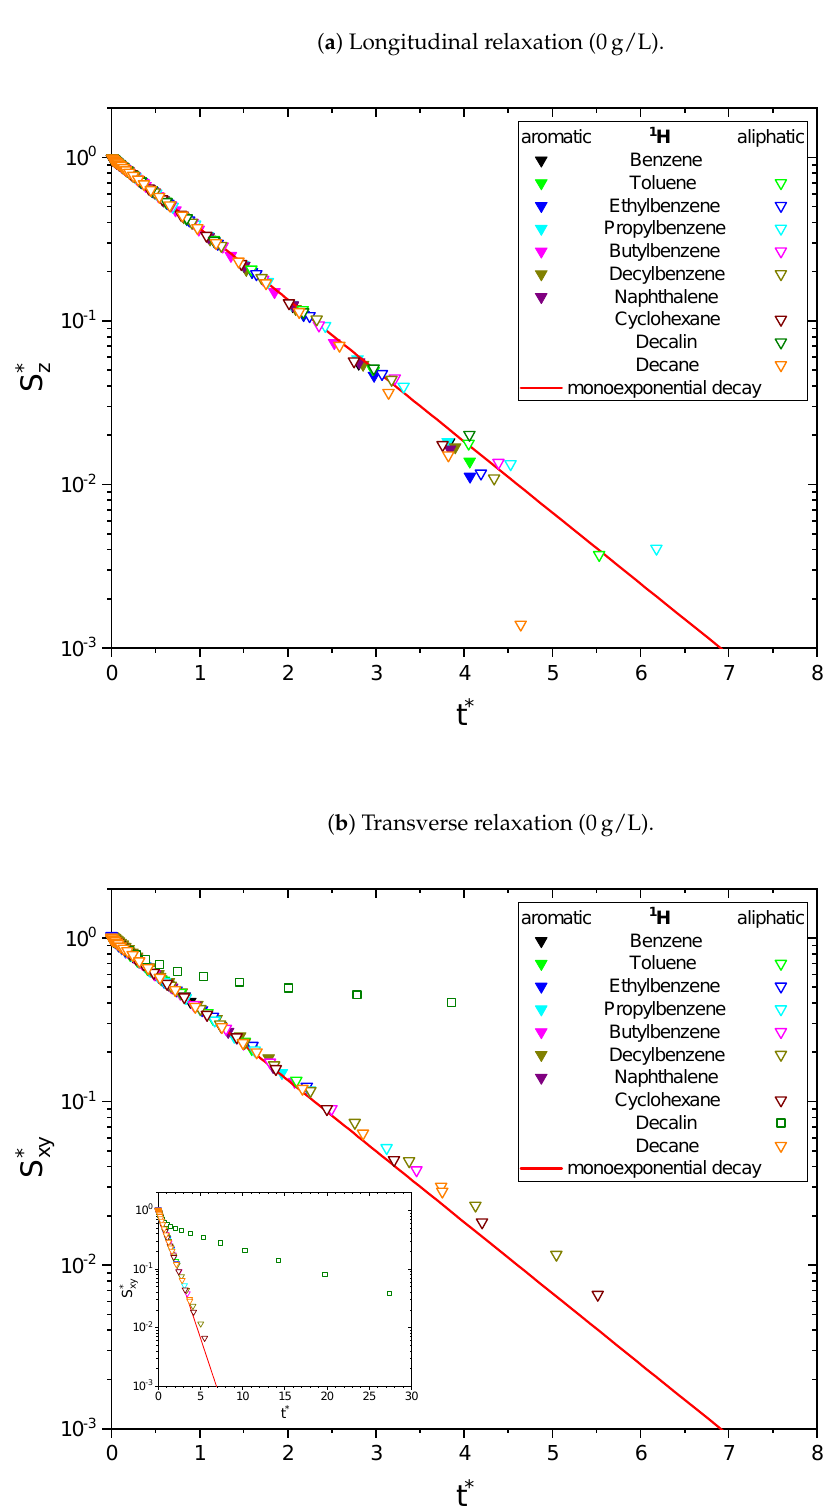
Figure 1. Longitudinal ( a ) and transverse ( b ) relaxation decays of the maltene protons in the asphaltene-free solution, consisting of 95vol% benzene-d 6 and 5vol% of the investigated maltene. The inset in ( b ) shows the whole measured range of the relaxation decay of decalin. For a qualitative comparison, the time axis is rescaled (see Equation (12)) to reflect multiples of R normalized to unity at t ∗ = 0 (see Equations (13) and (14)). The needed parameters were obtained from a monoexponential ( (cid:79) ) or biexponential ( (cid:3) )